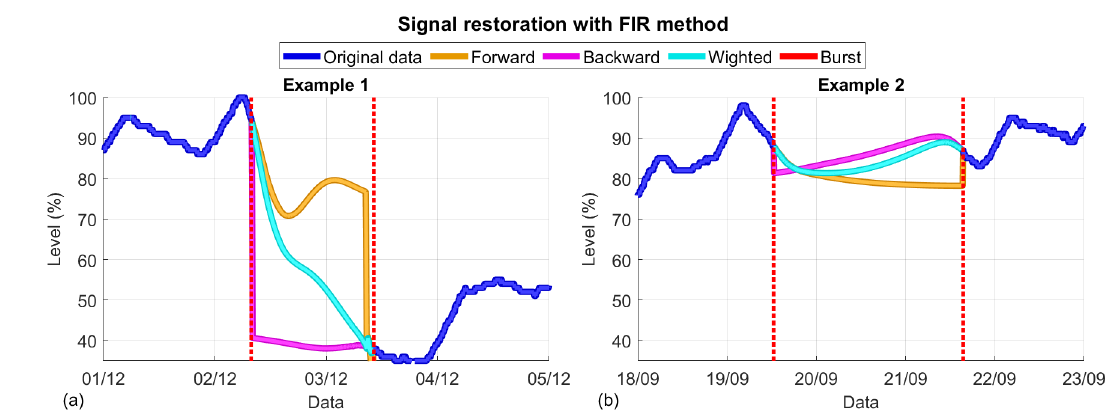
Figure 4. Particular cases of signal restoration with the FIR method: ( a ) shows a middle-length burst and ( b ) shows a large-length burst. In both cases, the forward and the backward FIR methods do not maintain the continuity of the signal but the Weighted FIR method does maintain such